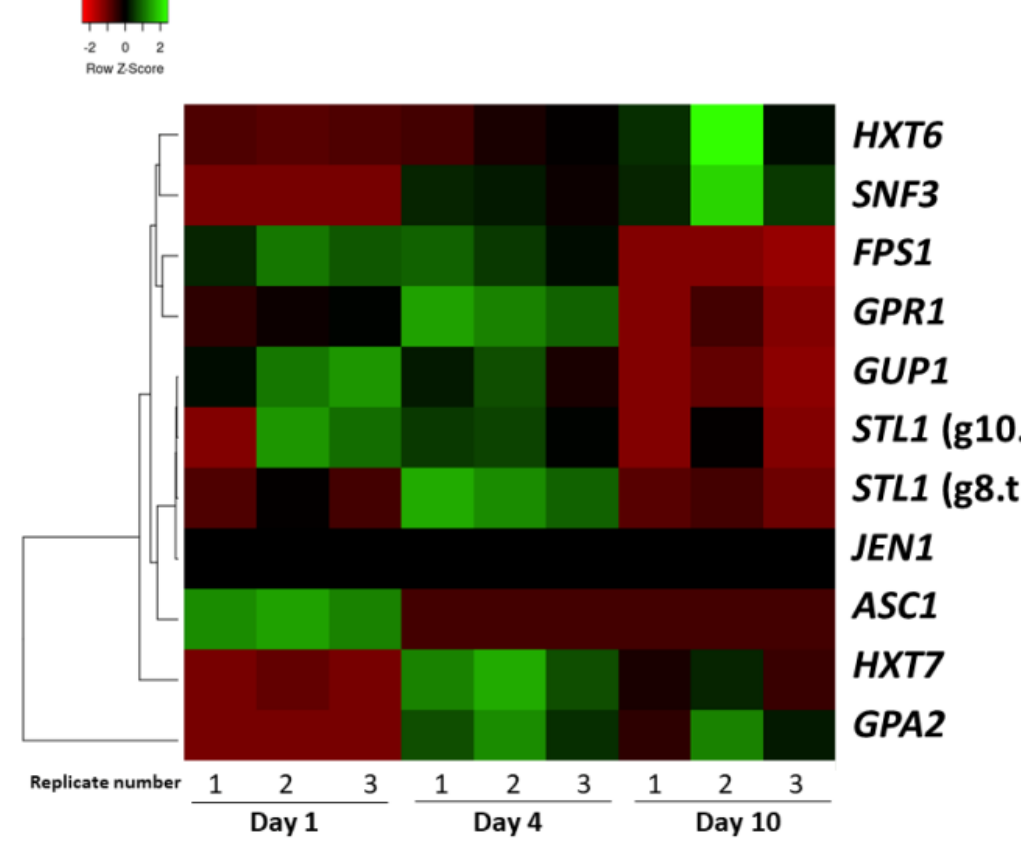
Figure 2. Heatmap depicting the expression levels of genes putatively involved in sugar detection and transport in H. vineae after 1, 4, and 10 d of fermentation. The green colour indicates elevated expression levels and the red colour indicates reduced expression levels. Data are shown in triplicate.